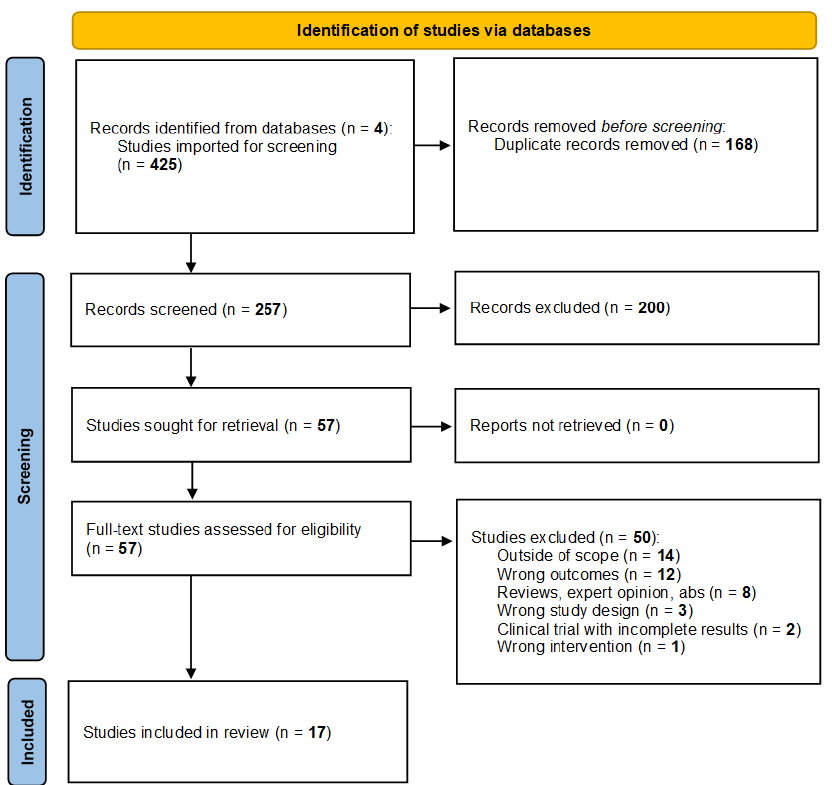
Figure 1. Flow diagram of the systematic search strategy and results conducted using Covidence systematic review software